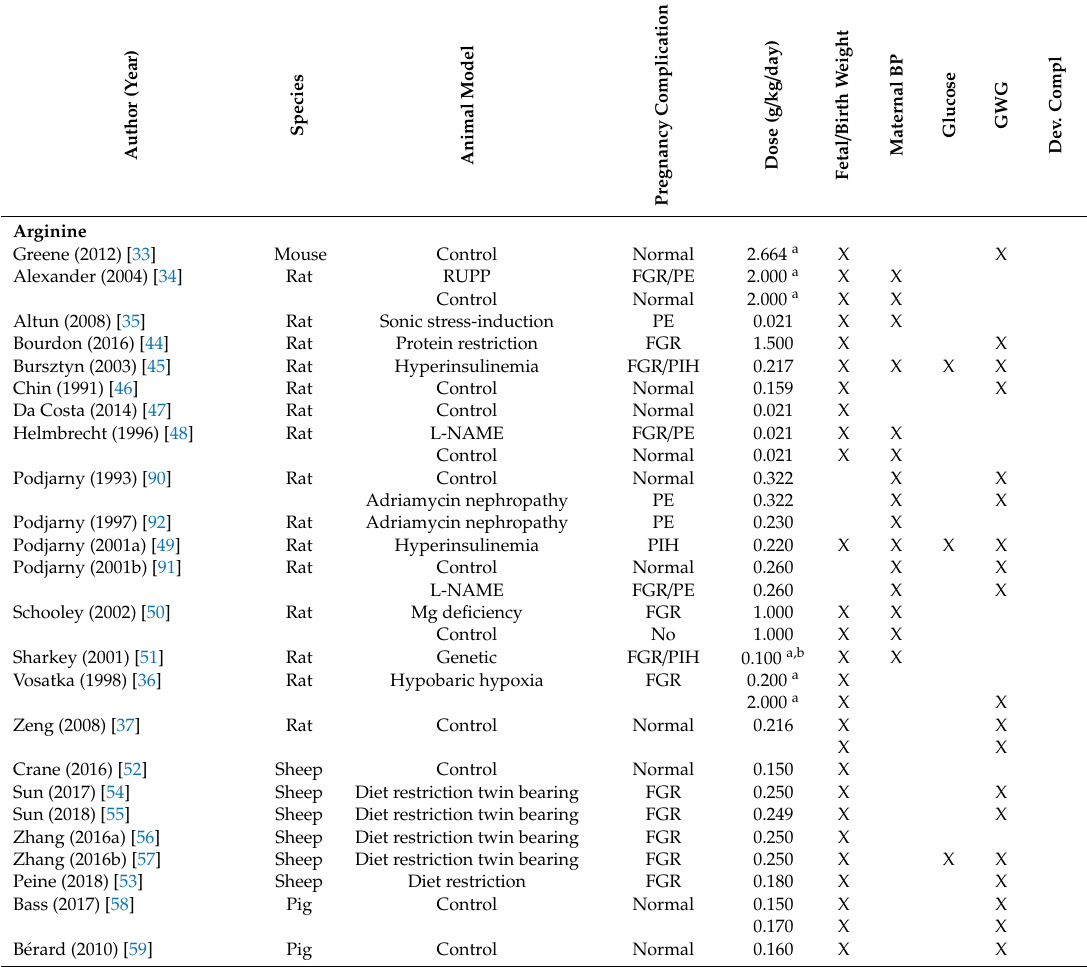
Table A4. Main study characteristics and reported outcome of included